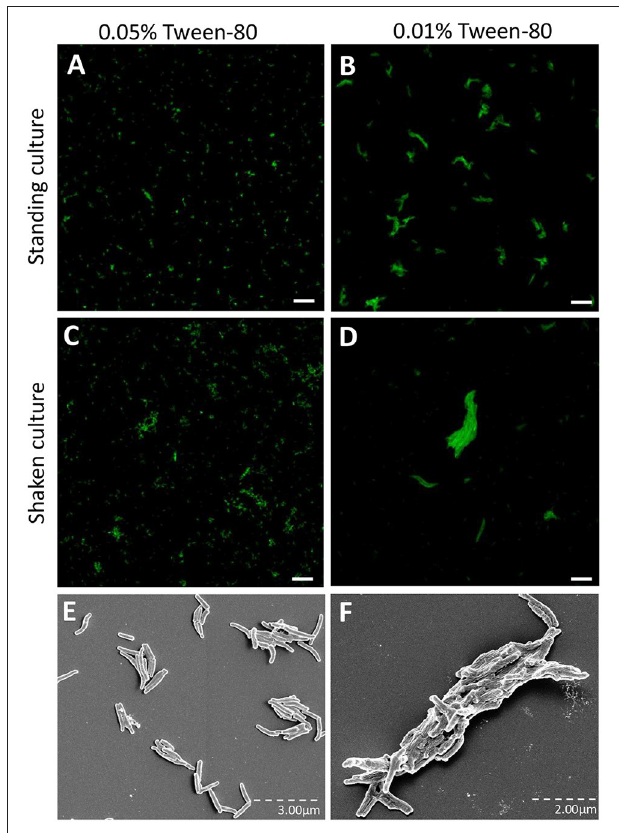
FIGURE 1 | H37Rv cultured in broth with reduced Tween-80 concentration and on a shaker form cords. GFP-expressing H37Rv was passaged and cultured in the presence of (A,C,E) 0.05% Tween or (B,D,F) 0.01% Tween for either (A,B,E) 7 days as a standing culture or (C,D,F) for 3 days on a shaker at 260 rpm. The bacteria were prepared with multiple passages through a 27-gauge syringe, incubated on cover slips overnight and fixed. Images were taken through either (A–D) confocal microscopy or (E,F) scanning electron microscopy. Bar: 20 µ